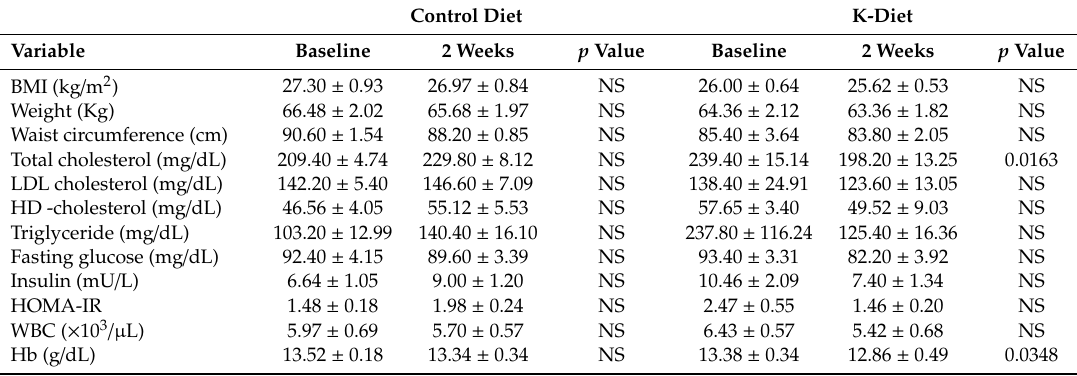
Table 3. Comparison of clinical endpoints before and after the